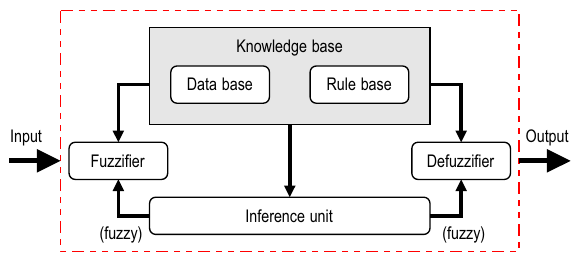
Fig. 6. Membership function for risk